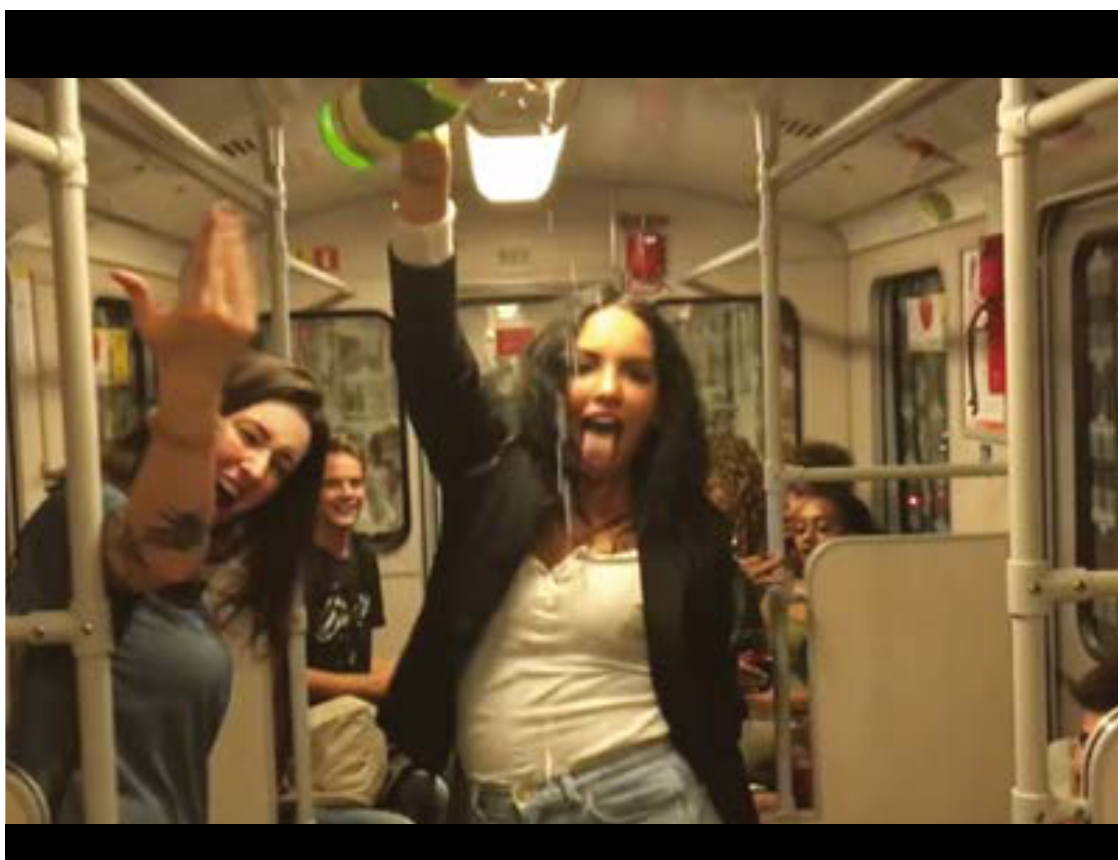
Figure 7—8 (left and right): Fotzen im Club by SXTN. Source: http://www.youtube.com/watch?v=NH9HRlyos80 screenshot. Accessed November 30, 2019. Figure 9—10 (page 46): Female Vampire by Jenny Hval. Screenshots: www.youtube.com/watch?v=ZVaWc00aZ30. Accessed November 30,